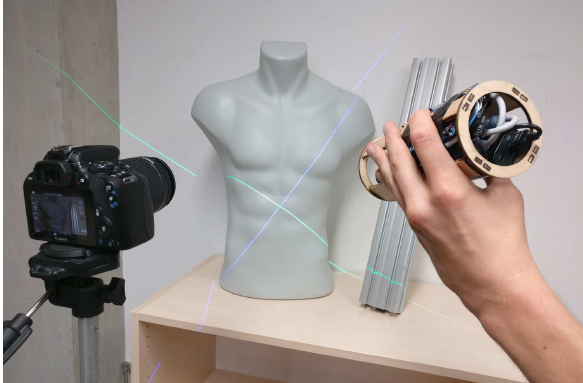
Figure 1: Fixed consumer camera and handheld cross line pro- jector with a blue and a green